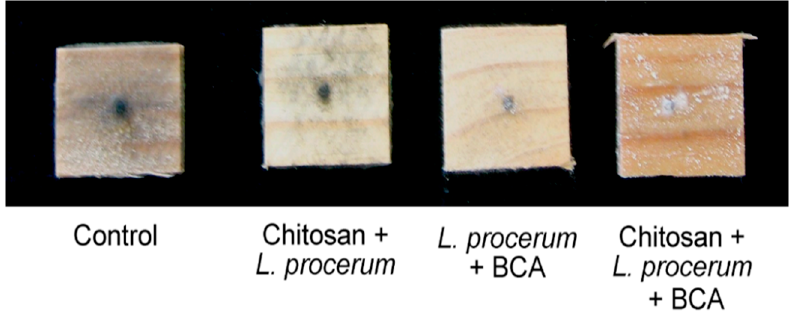
Figure 3. Effect of chitosan and BCA on L. procerum after 24 days of incubation.